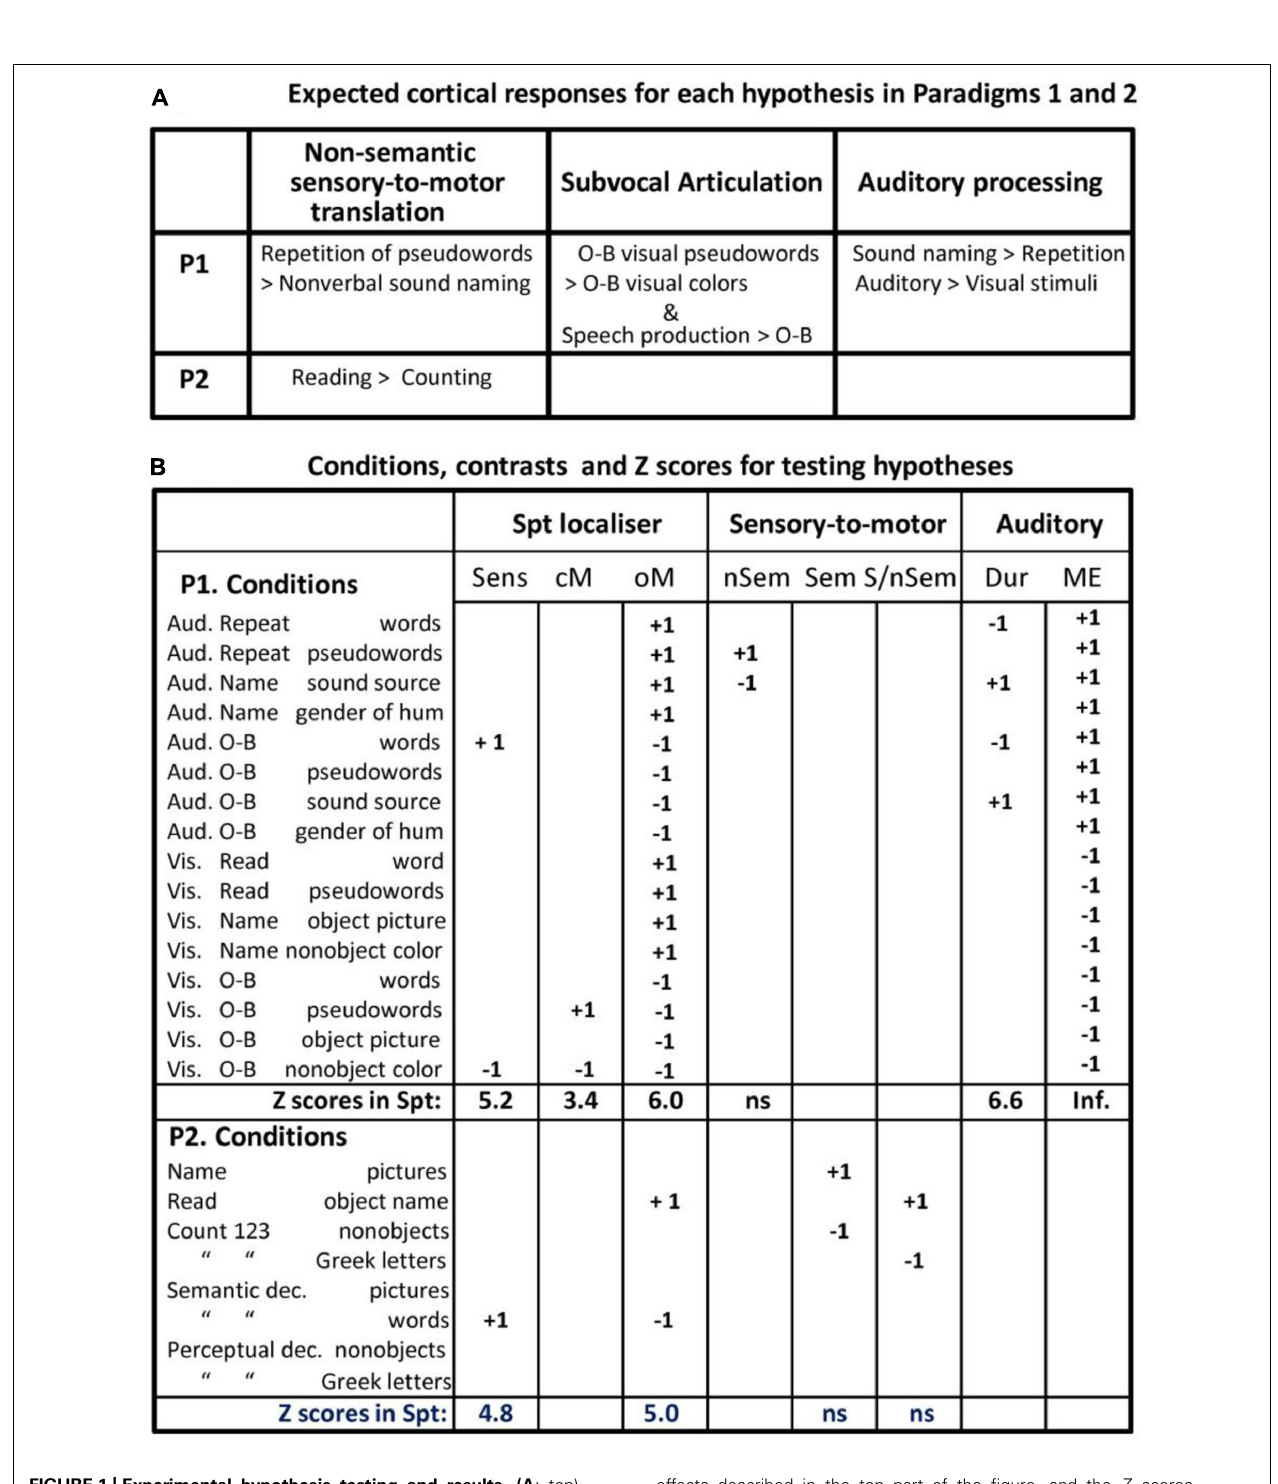
effects described in the top part of the figure, and the Z scores associated with each effect (i.e., the result). Aud = auditory presen- tation, Vis = visual presentation, O-B = one-back task, Articul. = Articulation, dec. = decision, Sens. = sensory speech input (no speech production), cM. = coverty mouth movements/articulation, oM. = overt mouth movements/articulation, nSem. = non-semantic, Sem. = seman- tic, S/nSem. = semantic and non-semantic, Dur. = auditory stimuli with long vs. short durations, ME. = main effect of auditory input, ns. = not